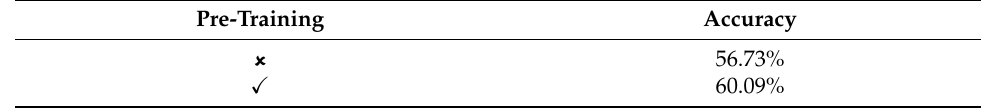
Figure 11. Polypseudorotaxanes inter- or intra-crosslink with each other via hydrogen bonding. Table 9. Accuracy indexes of research on pre-training. Table 2. Ten percent 10KPEGMA and 10% P-10K solutions with 10% α -CD.